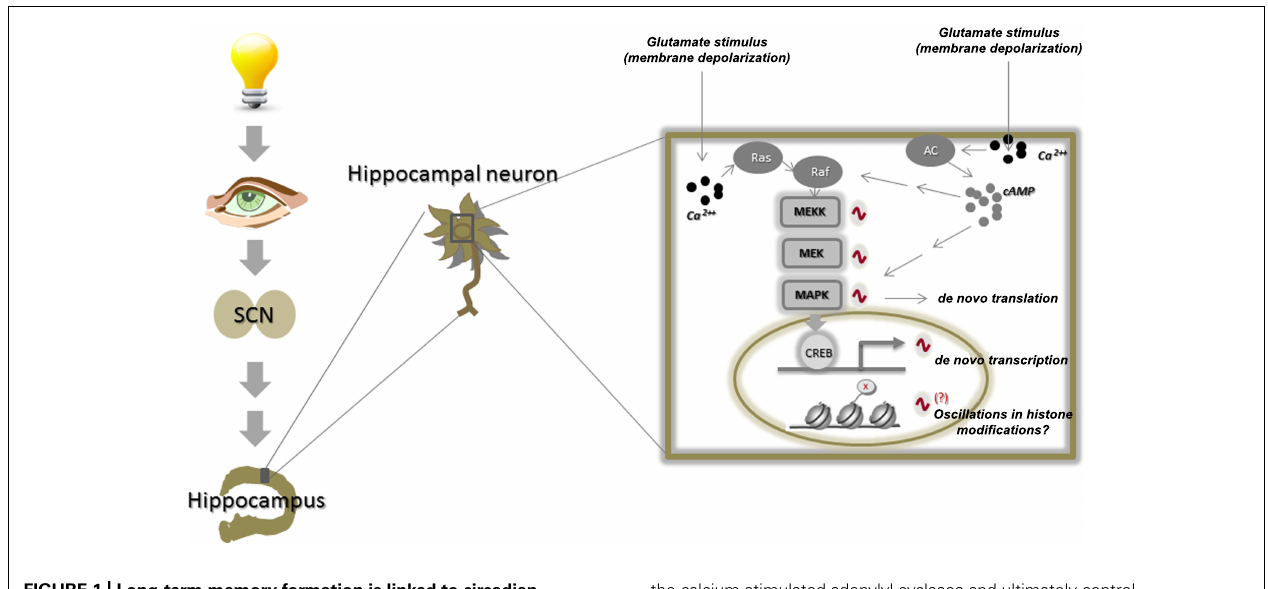
FIGURE 1 | Long-term memory formation is linked to circadian time and the suprachiasmatic nucleus. Activity oscillations within the MAPK pathway are dependent on the SCN, ultimately linking them to external zeitgebers such as light. Oscillations of the MAPK pathway depend on the rhythmic activation of Ras activity as well as that of